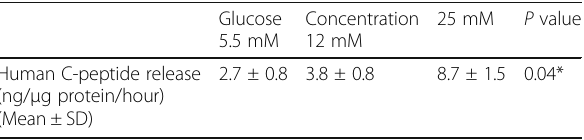
Table 3 In vitro C-peptide release in response to increasing glucose concentration